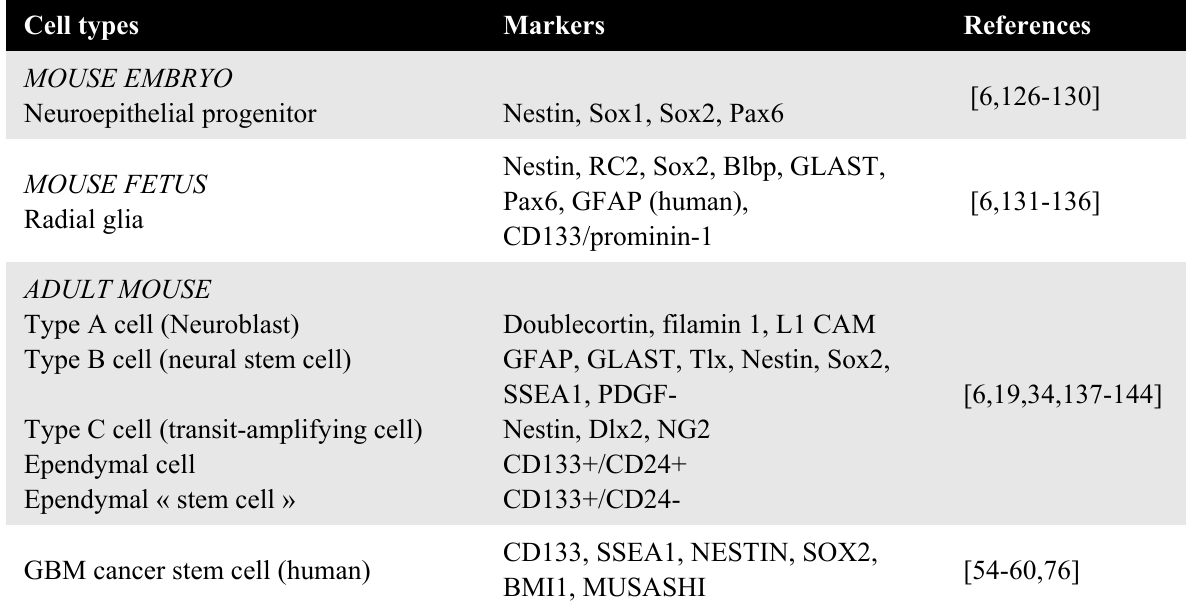
Table 1. Molecular markers associated with neural stem cells, progenitors, and cancer